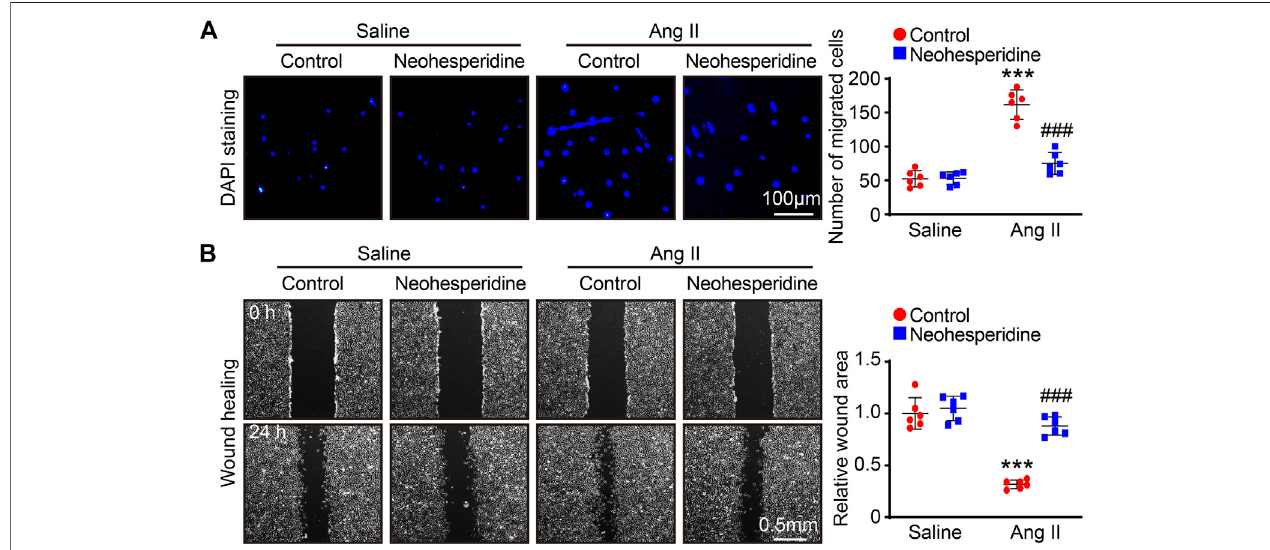
FIGURE 6 | Neohesperidin inhibits Ang II-induced VSMCs migration. After cells were treated with Neohesperidin was (20 μ m) for 24 h, Ang II (2 μ m) were added into cells for 24 h (A) Representative images of DAPI staining from each group and Histogram of the number of VSMCs ( n = 6) (B) Representative images of wound- healingfromeachgroupandHistogramoftherelativewoundareaofeachgroup( n =6).Statisticalanalysiswasperformedwithone-wayANOVA.*** p < 0.001,shamvs. Ang II; ### p < 0.001, Ang II vs. Ang II + Neohesperidin.